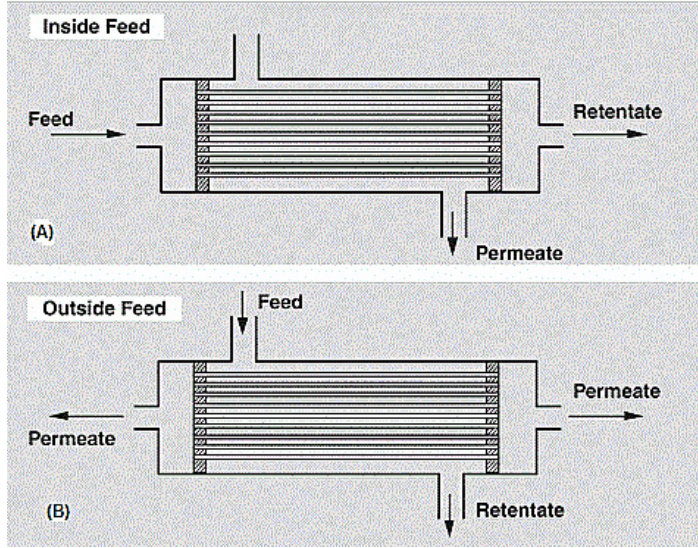
Figure 10. ( A ) Bore side feed hollow fiber membrane modules, ( B ) Shell side feed hollow fiber membrane module. Adapted from [122]